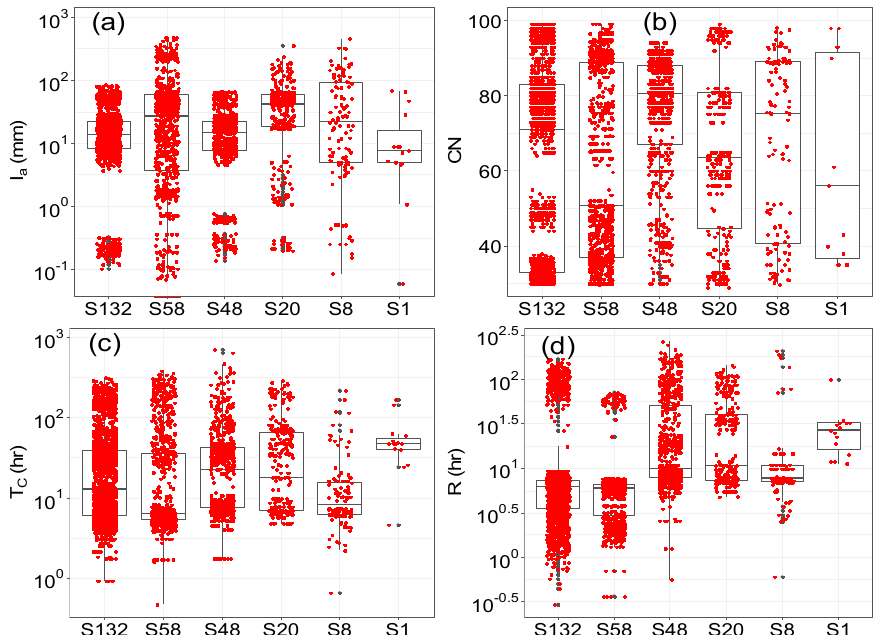
Figure 3. Boxplots of the calibrated parameter for 15 events, for six configurations. Each panel corresponds to a parameter, and panels in the clockwise direction from the top left, ( a ), ( b ), ( c ) and ( d ) correspond to I a , CN, T c and R, respectively. The red color-filled circle corresponds to a value of the parameter of an event of a sub-basin of a configuration. The filled circles for any value are arranged randomly in the boxplot along the width of the box. The boxplot with filled circles highlights the distribution aspects of the parameter values.